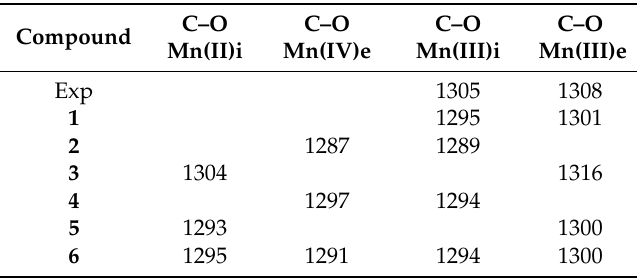
Figure 3. Experimental IR spectrum of 1 with a zoom of C – O vibration adjusted with Gaussians. Table 4. Values of vibrations of C–O Ph groups coordinated to manganese ions obtained experimentally (Exp) and DFT estimations from models 1 - 6 . Values in cm − 1